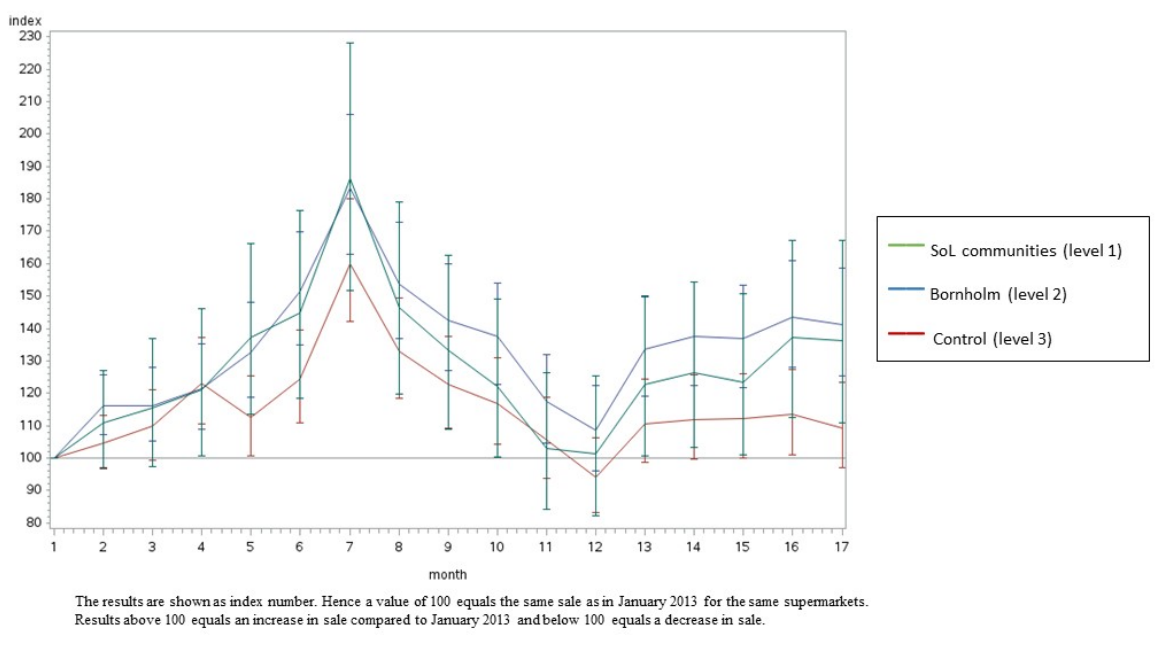
Figure 4. The development in monthly sales of vegetables (total) from January 2013 to June 2014 in the SoL intervention communities, the Island of Bornholm and the control area (Odsherred). Data are shown as index numbers.